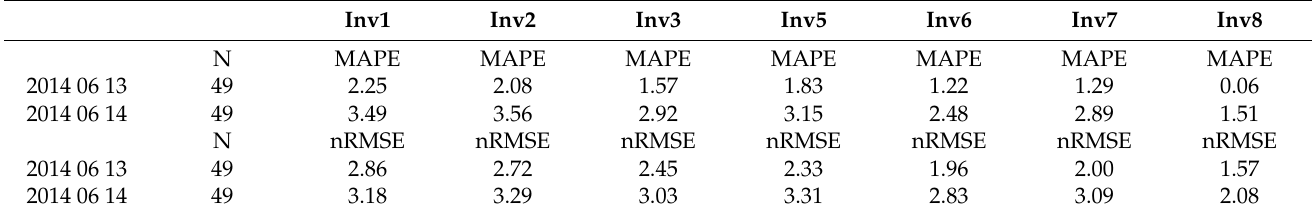
Table 4. Statistical metrics: MAPE and nRMSE for all inverters of PVS1 for the dates presented in Figure 3. Inverter 4 is not included since it was employed as a training